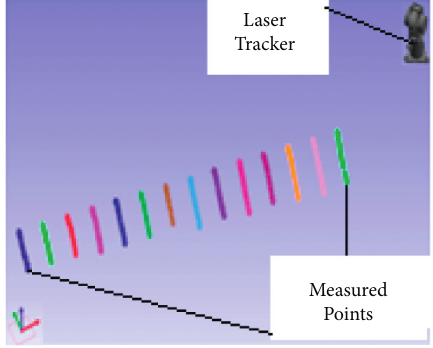
Figure 6: Laser tracker and measurement points.